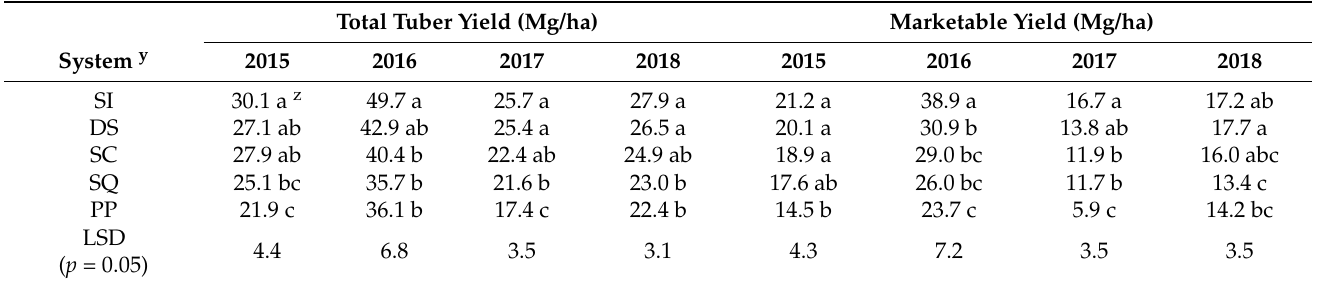
Table 3. Effect of different cropping systems on total tuber yield and marketable yield each year from 2015 to 2018. Total Tuber Yield (Mg/ha) Marketable Yield